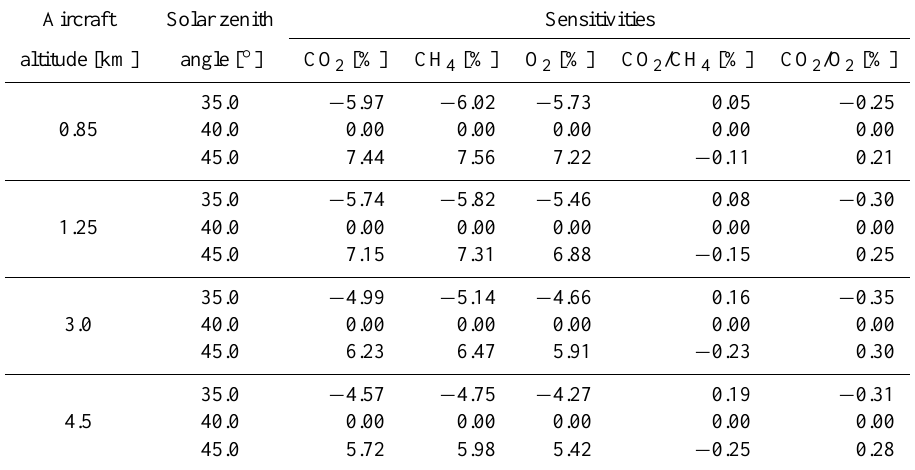
Table 2. Solar zenith angle sensitivity of total column concentrations and their ratios for different aircraft altitudes, if the true solar zenith angle is deviating from the 40 ◦ assumed for the retrieval.